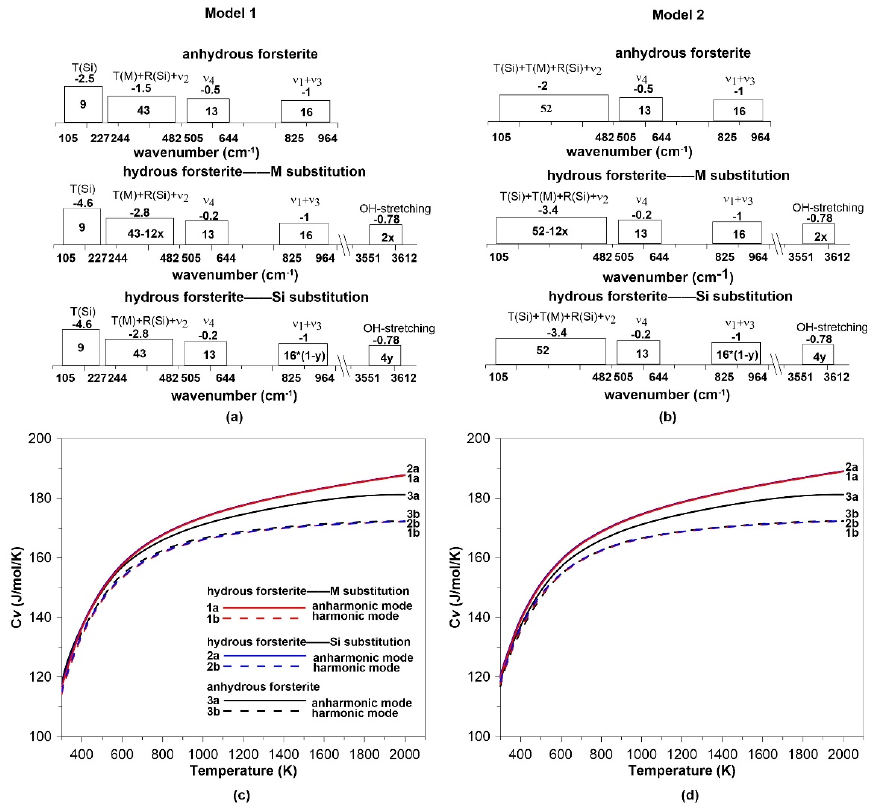
Figure 10. Modes of density of states for anhydrous and hydrous forsterite from ( a ) Model 1 [67] and ( b ) Model 2 [50]. The formula is Mg 2−x H 0.138 SiO 4 (x = 0.0686) and Mg 2 H 0.138 Si 1−y O 4 (y = 0.0345) assuming all OH with M-substitution and Si-substitution, respectively. The values x = 0.0686 and y = 0.0345. The boxes denote the continua for different groups of optical modes. The upper and lower cutoff frequencies for each continuum are also labeled below the box. The numbers inside and above each box represent the number of modes and the mean ( a i ) parameter for the vibrational modes in each continuum (Figure 9 and Supplementary Table S1), respectively. Comparisons for the isochoric heat capacities, C V , for anhydrous and hydrous forsterite samples are made in ( c ) (Model 1) and ( d ) (Model 2).